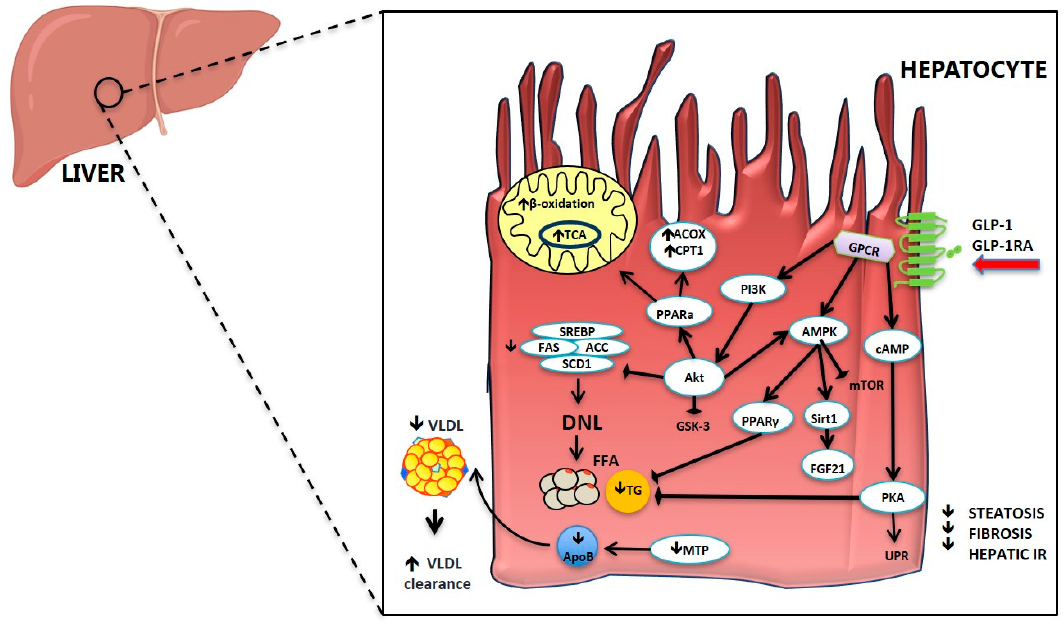
Figure 2. Mechanistic effects of GLP-1 and GLP-1 receptor agonists in hepatic lipid metabolism. GLP-1 and GLP-1 receptor agonists act via G protein-coupled receptors (GPCRs) in hepatocytes to target several signaling pathways, resulting in increased β -oxidation in mitochondria, decreased hepatic mRNA expression of several lipogenic genes (SREBP1, FAS, ACC and SCD1), reduced de novo lipogenesis (DNL) and reduced steatosis. Abbreviations: ACC, Acetyl-CoA carboxylase α ; ACOX, Peroxisomal acyl-coenzyme A oxidase; Akt, Serine/threonine protein kinase B/Akt; AMPK, 5’ AMP-activated protein kinase; ApoB, Apolipoprotein B 100; cAMP, Cyclic adenosine monophosphate; CPT1, Carnitine palmitoyltransferase 1; DNL, de novo lipogenesis; FAS, Fatty acid synthase; FFA, Free fatty acids; FGF21, Fibroblast growth factor 21; GLP-1, Glucagon-like peptide-1; GLP-1RA, Glucagon-like peptide-1 receptor agonists; GPCR, G-protein-coupled receptors; GSK-3, Glycogen synthase kinase 3; MTP, Microsomal triglyceride transfer protein; mTOR, mammalian target of rapamycin; PI3K, Phosphoinositide 3-kinase; PKA, Protein kinase A; PPAR, Peroxisome proliferator-activated receptor; SCD1, Stearoyl-CoA desaturase 1; Sirt1, Sirtuin 1; SREBP, Sterol regulatory element-binding protein; TCA, Tricarboxylic acid cycle; TG, Triglyceride; UPR, Unfolded protein response; VLDL, Very-low-density lipoprotein.